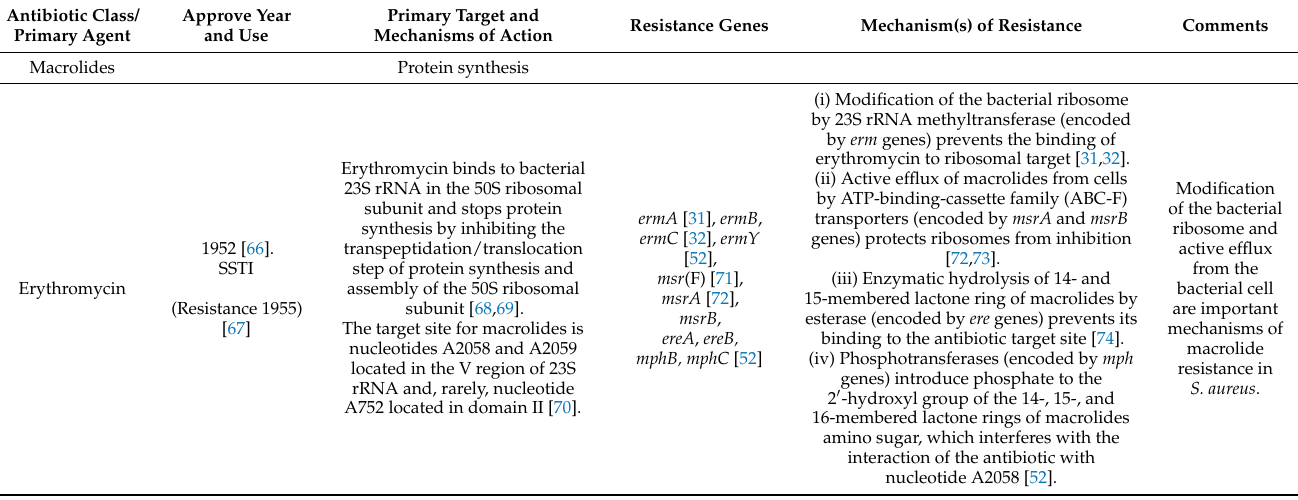
Table 1. Mechanisms of action of non- β -lactam antibiotics active against S. aureus and molecular basis of antibiotic